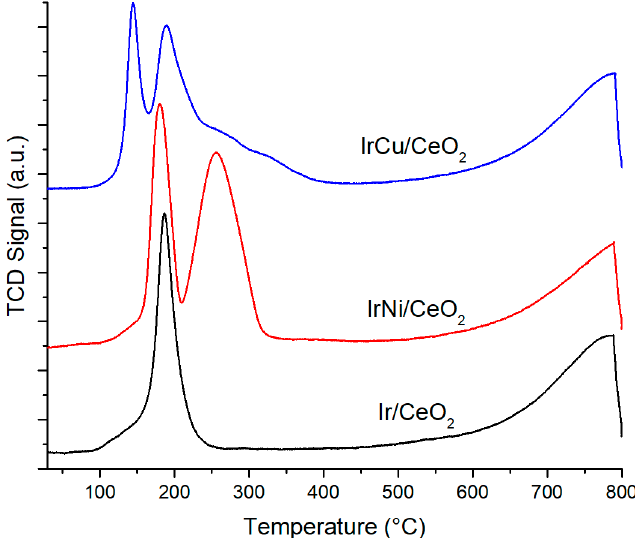
Figure 9. CeO 2 -supported catalysts TPR profile.